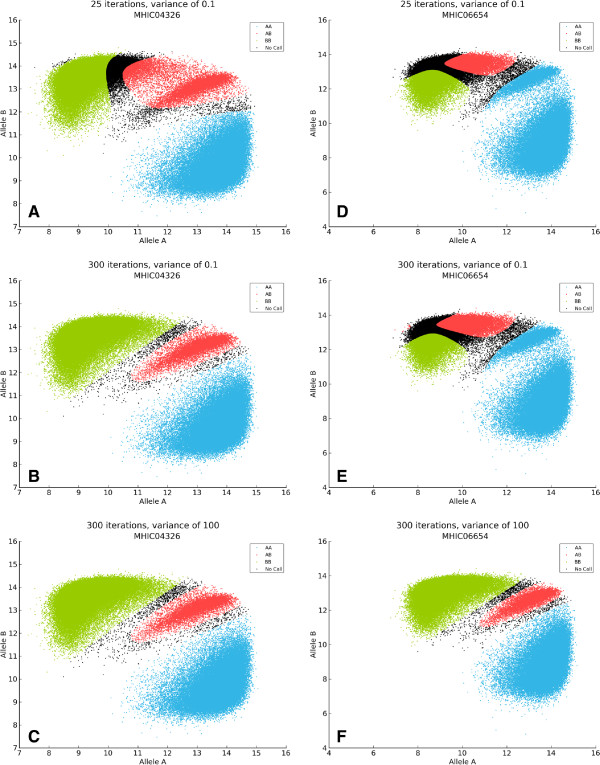
Impact of parameters on GenoSNP’s clustering. Impact of the choice of initial parameters on GenoSNP’s clustering of two samples (MHIC04326 shown in (A), (B) and (C), and MHIC06654 shown in (D), (E) and (F)). The first row shows the clustering results of the two samples using the default parameters (25 EM iterations and an initial variance of 0.1). The second row shows the results when keeping an initial variance of 0.1, but increasing the number of EM iterations to 300. The last row shows the results when increasing both the initial variance and the number of EM iterations to 100 and 300, respectively. In all cases, only markers in the BeadPool 1 are kept. Each point represents the raw B allele intensities against the raw A allele intensities (base two logarithm in both cases) of each marker. The AA, AB and BB genotypes are shown in blue, red and green, respectively. Markers that were below the quality threshold of 0.8 are shown in black.